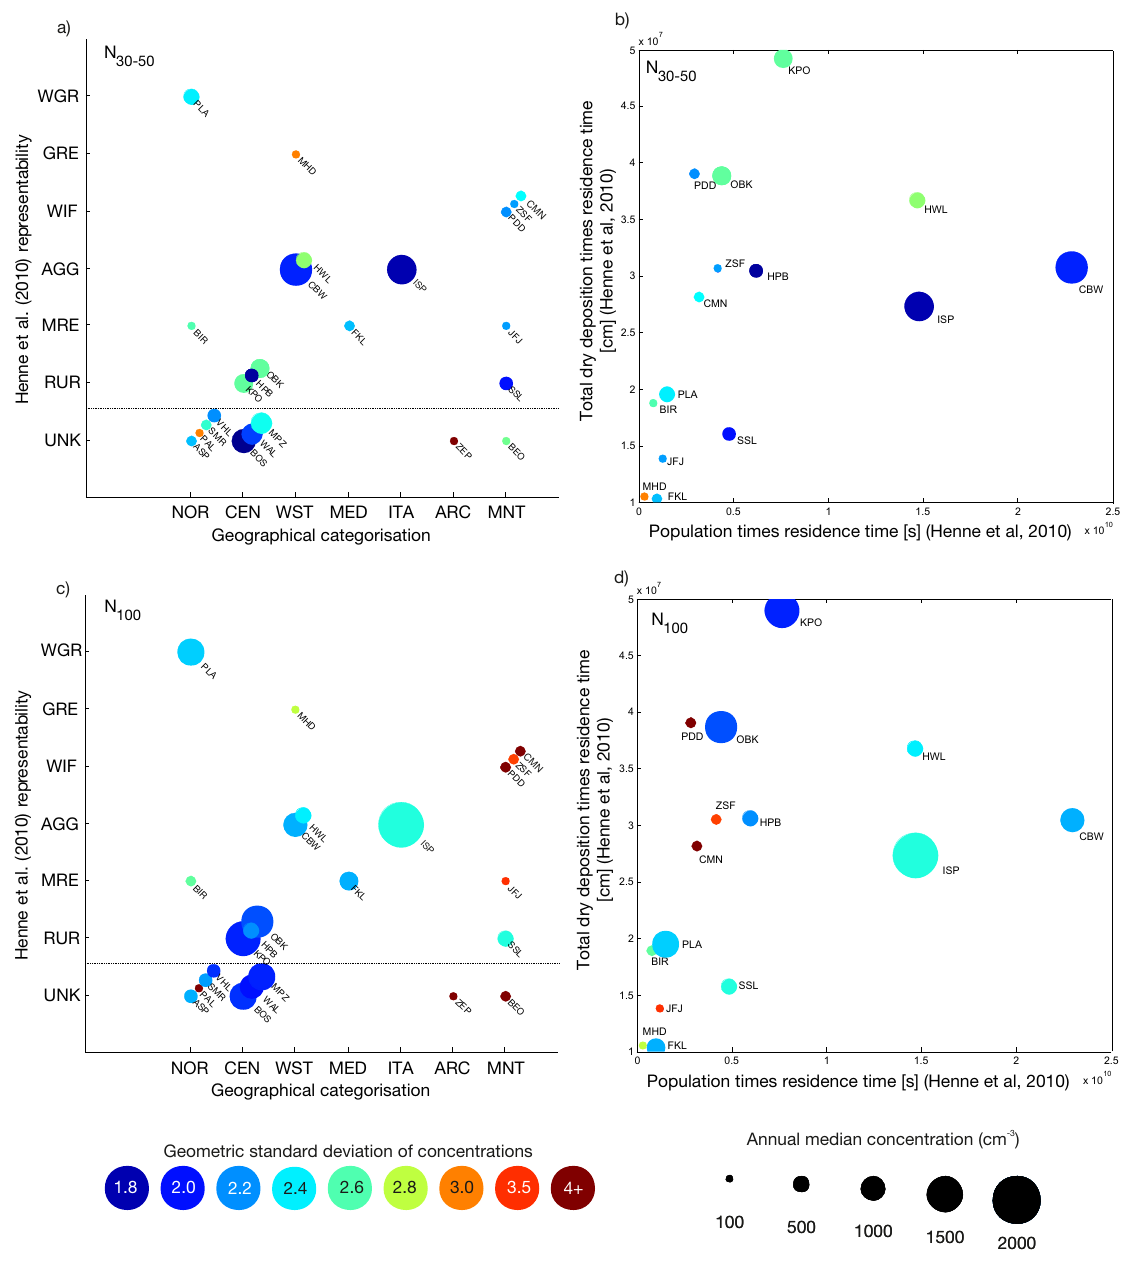
Fig. 12. Station categorisation according to geographical location and Henne et al. (2010) (see text) (a) and (c) . The category abbreviations are: WGR – “Weakly influenced, generally remote”, GRE – “generally remote”, WIF – “weakly influenced”, AGG – “agglomeration”, MRE – “mostly remote”, RUR – “Rural”, UNK – unknown, not categorized. The geographical areas are NOR – Nordic and Baltic, CEN – Central Europe, WST – Western Europe, MED – Mediterranean, ITA – North Italy, ARC – Arctic, MNT – Mountains. (a) for N 30 − 50 concentrations and (c) for N 100 . On subfigures (b) and (d) are shown the station concentrations and standard deviations as function of Henne et al. (2010) main categorizing parameters, the “catchment area population times residence time” and the “catchment area total O 3 deposition times residence time”. The values are from 24h catchment areas. The colour of the station indicators describe the annual geometric standard deviations of the concentrations in question and the sizes of the indicators show the annual median number